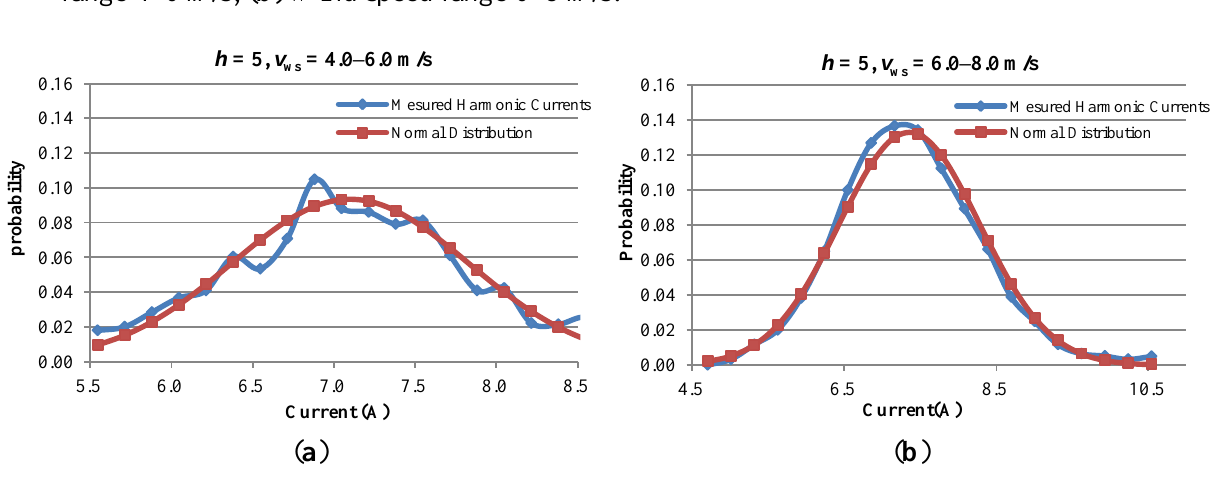
Figure 8. Probability density distributions of the 5th harmonic currents. ( a ) Wind speed range 4–6 m/s; ( b ) Wind speed range 6–8 m/s.